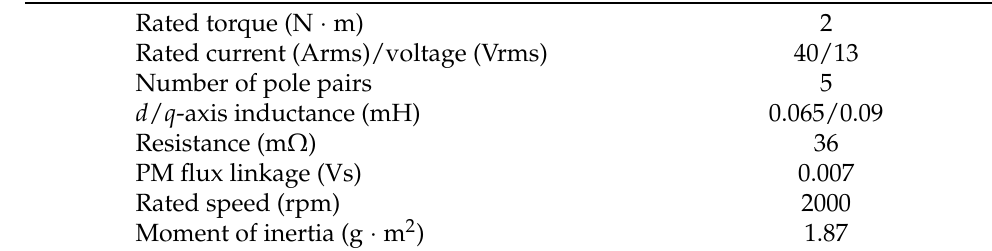
Table 1. Parameters of the